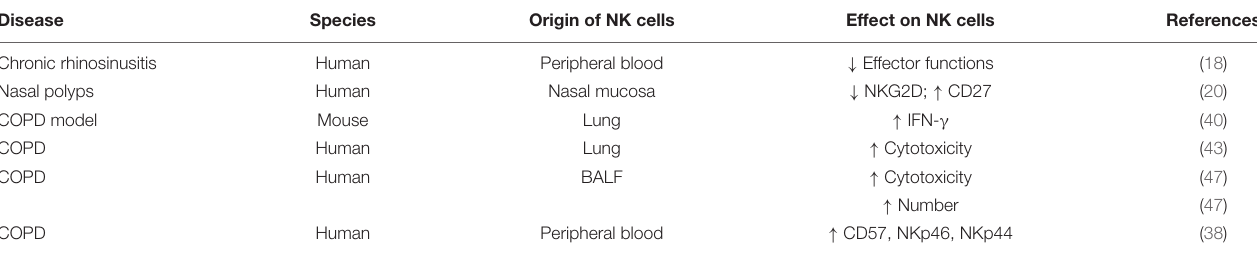
TABLE 1 | Natural Killer (NK) cells in airway